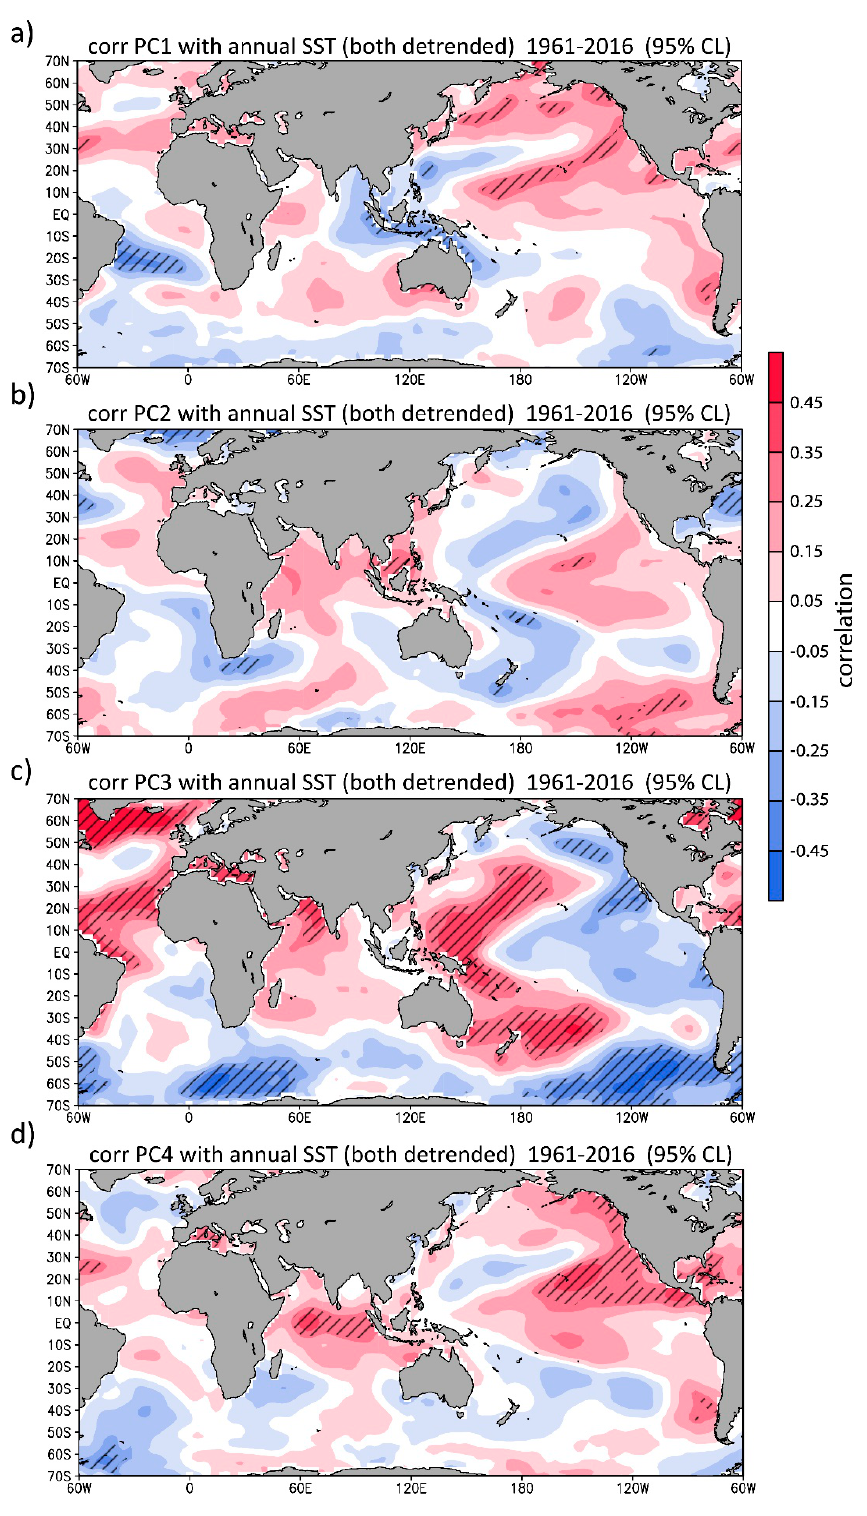
Figure 6. Temporal correlation of annual precipitation principal component (PC) to annual sea surface temperature (SST) for the 1961–2016 period. Both variables are detrended. ( a ) PC1 correlation with SST, ( b ) PC2 correlation with SST, ( c ) PC3 correlation with SST, and ( d ) PC4 correlation with SST. Hatched areas indicate significant values with confidence level > 95%.